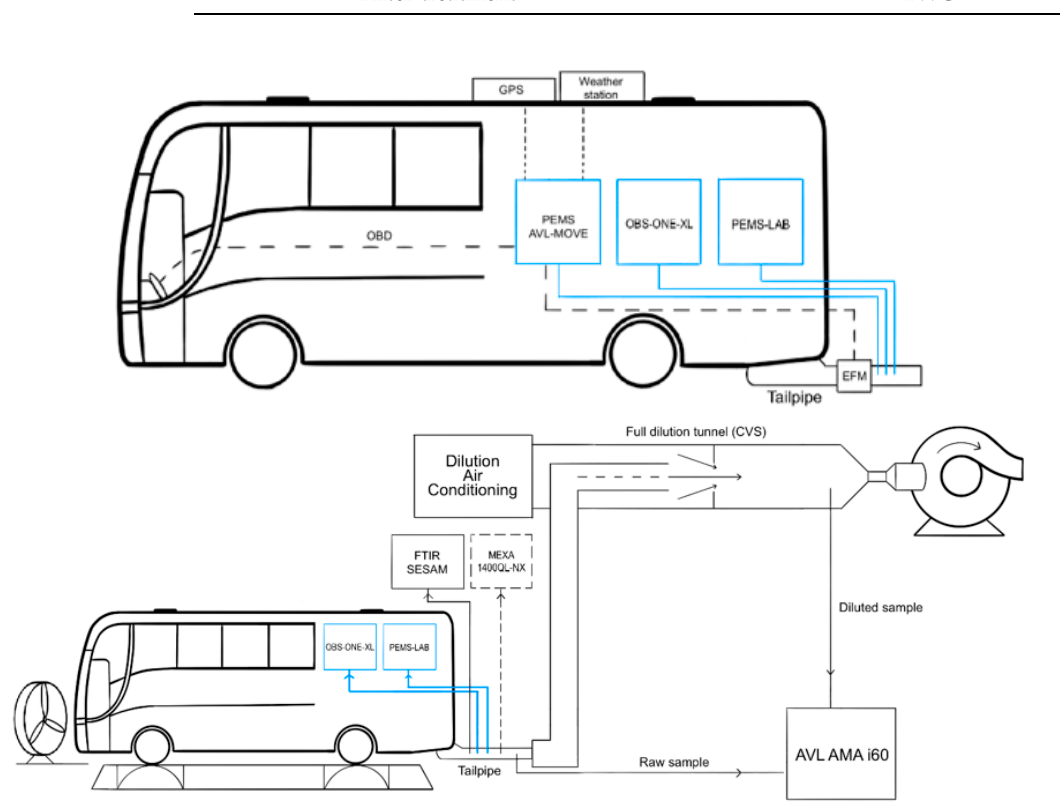
Figure 1. Measurement setup used during the tests performed on-road ( top ) and at VELA7 ( bottom ).